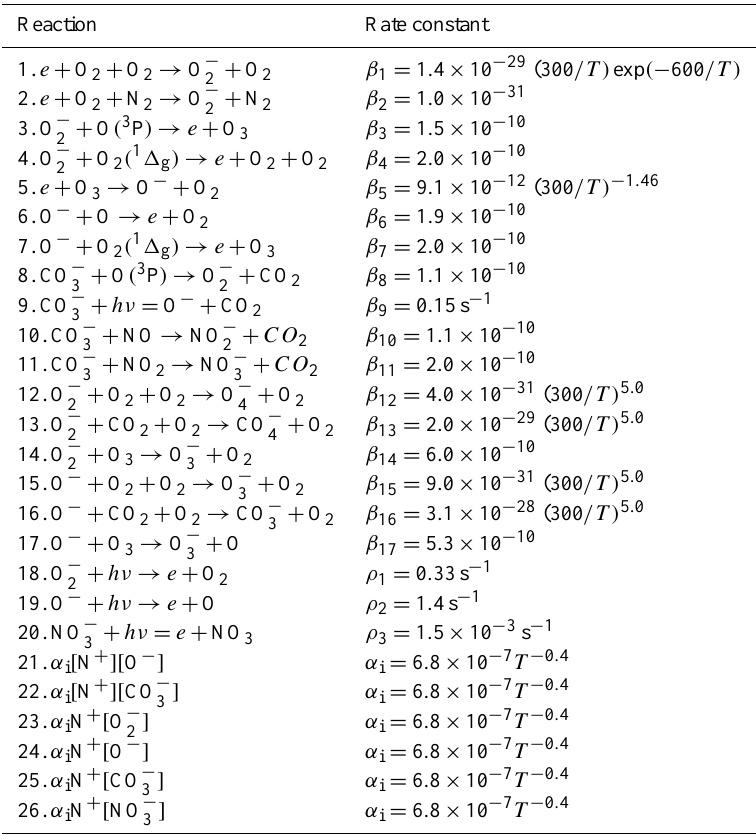
Table 2. Rate constants for the reactions leading to the formation and loss of the O − 1983a, b) chemical